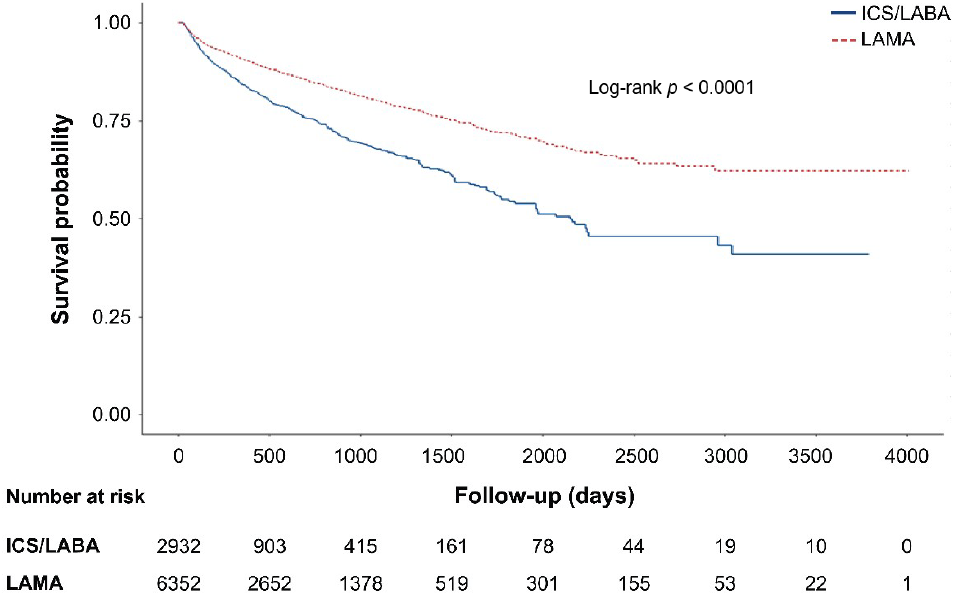
Figure 2. Survival curve of patients under two treatments (long-acting muscarinic antagonist (LAMA) vs. inhaled corticosteroids/long-acting beta2 agonist (ICS/LABA) until escalation to triple combination therapy.